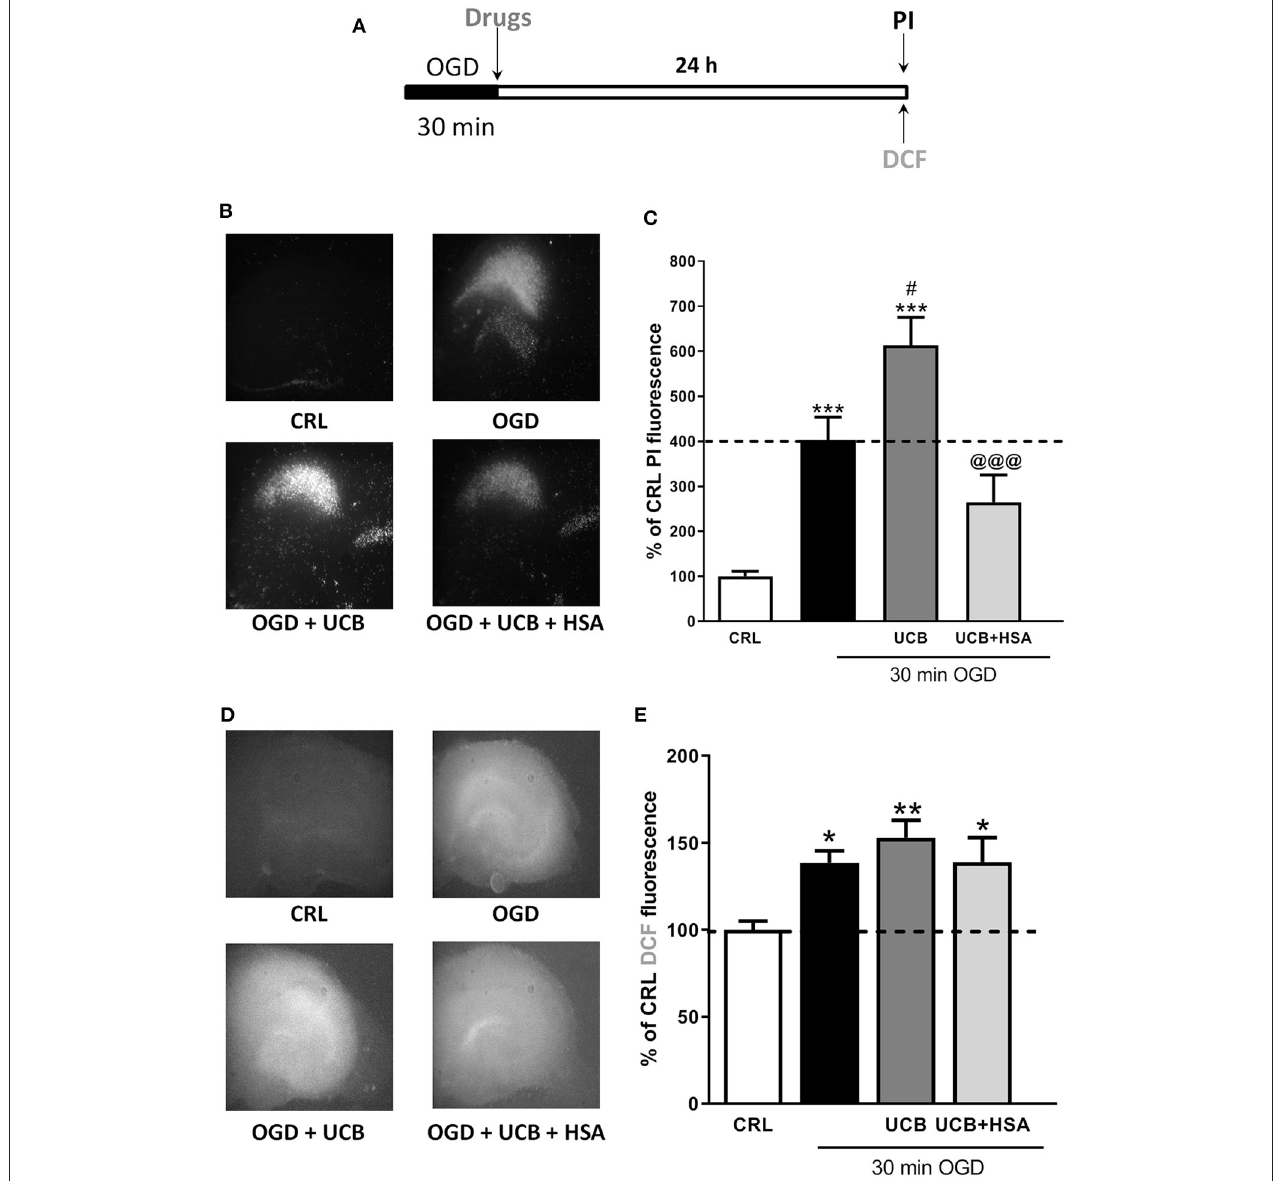
FIGURE 1 | Effects of HSA on UCB-induced-toxicity and ROS production in OGD mature organotypic hippocampal slices. (A) Experimental protocol showing mature hippocampal slices exposed to 100 µ M of UCB alone or plus HSA (100 µ M) for 24h immediately after 30min OGD. (B) Qualitative analysis shows that the CA1 damage induced by OGD is enhanced by UCB whose effect is abolished by equimolar concentration of HSA. (C) Quantitative analysis of PI fluorescence: Bars represent the mean ± SEM of at least seven experiments (about ≥ 28 slices for each experimental point). * P < 0.05 vs. CRL; ** P < 0.01 vs. CRL; *** P < 0.001 vs. CRL; # P < 0.05 vs. OGD; @@@ P < 0.001 vs. UCB. (D) Qualitative analysis shows that oxidative stress induced by OGD is enhanced by UCB (100 µ M), whose effect is abolished by equimolar concentration of HSA. (E) Quantitative analysis of DCFH2-DA fluorescence: Bars represent the mean ± SEM of at least seven experiments (about ≥ 28 slices for each experimental point). * P < 0.05 vs. CRL; ** P < 0.01 vs.